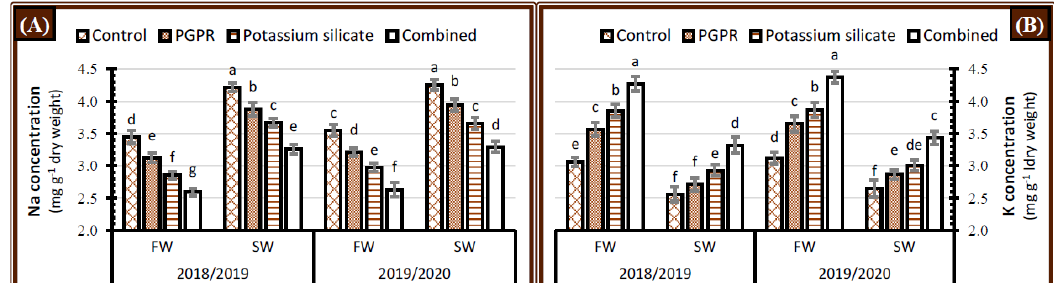
Figure 3. Effect of application of PGPR, potassium silicate and their combination on the concentration of ( A ) sodium ions and ( B ) potassium ions in faba bean leaves growing under two irrigation types, i.e., fresh water (FW) and saline water (SW) in salt-affected soil during two growing seasons 2018/2019 and 2019/2020. The data are means ± SD of four replicates. Means values that have the same lower-case letter in each column per season are not significant according to Duncan’s Multiple Range Test.